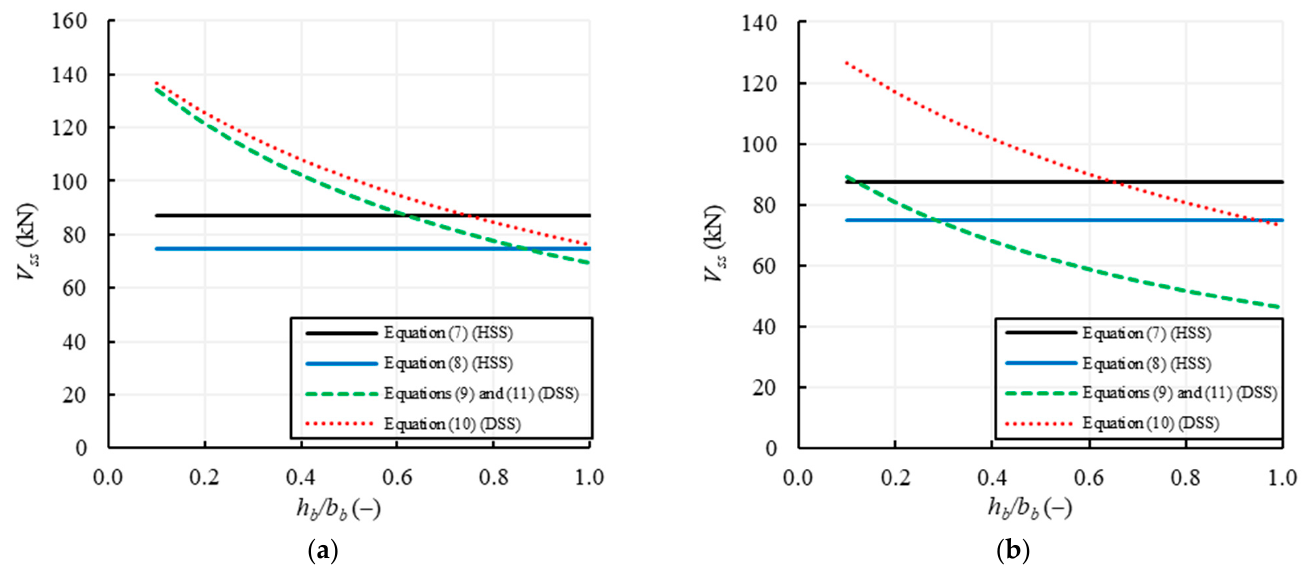
Figure 9. Sensitivity analysis for the shear capacity in regular masonry in function of h b /b b for f v0 = 0.25 MPa, µ = 0.58, and for: ( a ) λ = 1; ( b ) λ = 1.5.